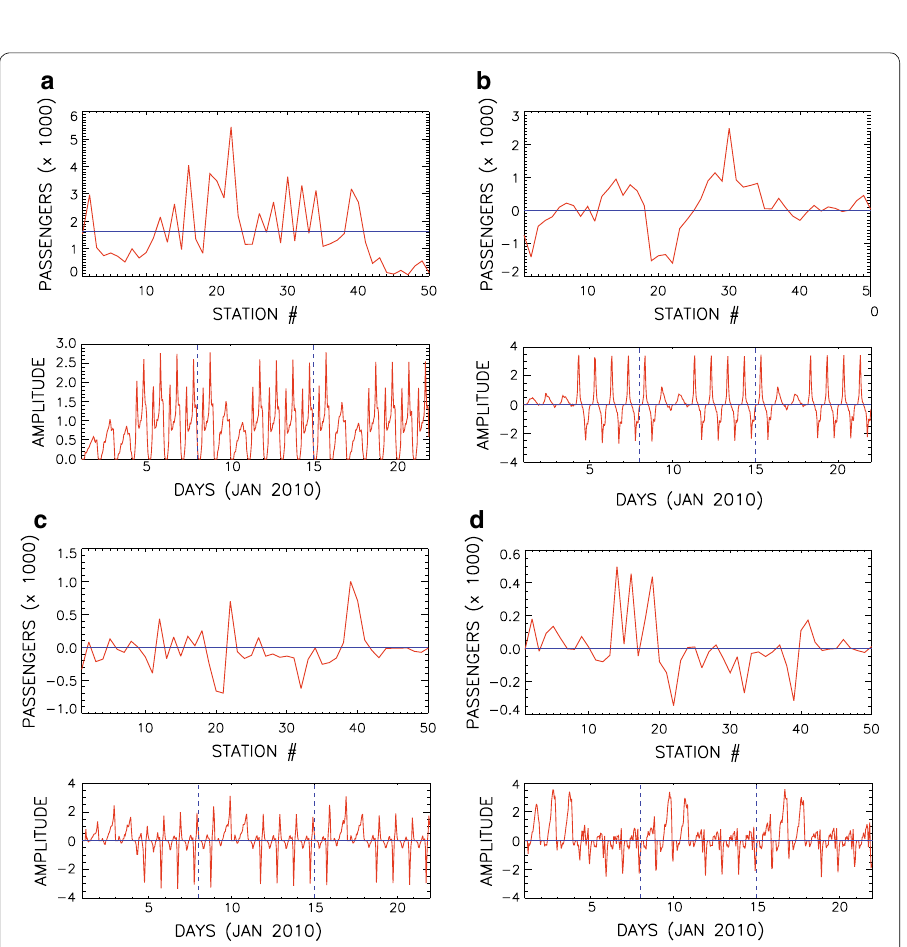
Fig. 11 The loading vector (upper panel) and PC time series (lower panel) of the first four ( a – d ) EOF